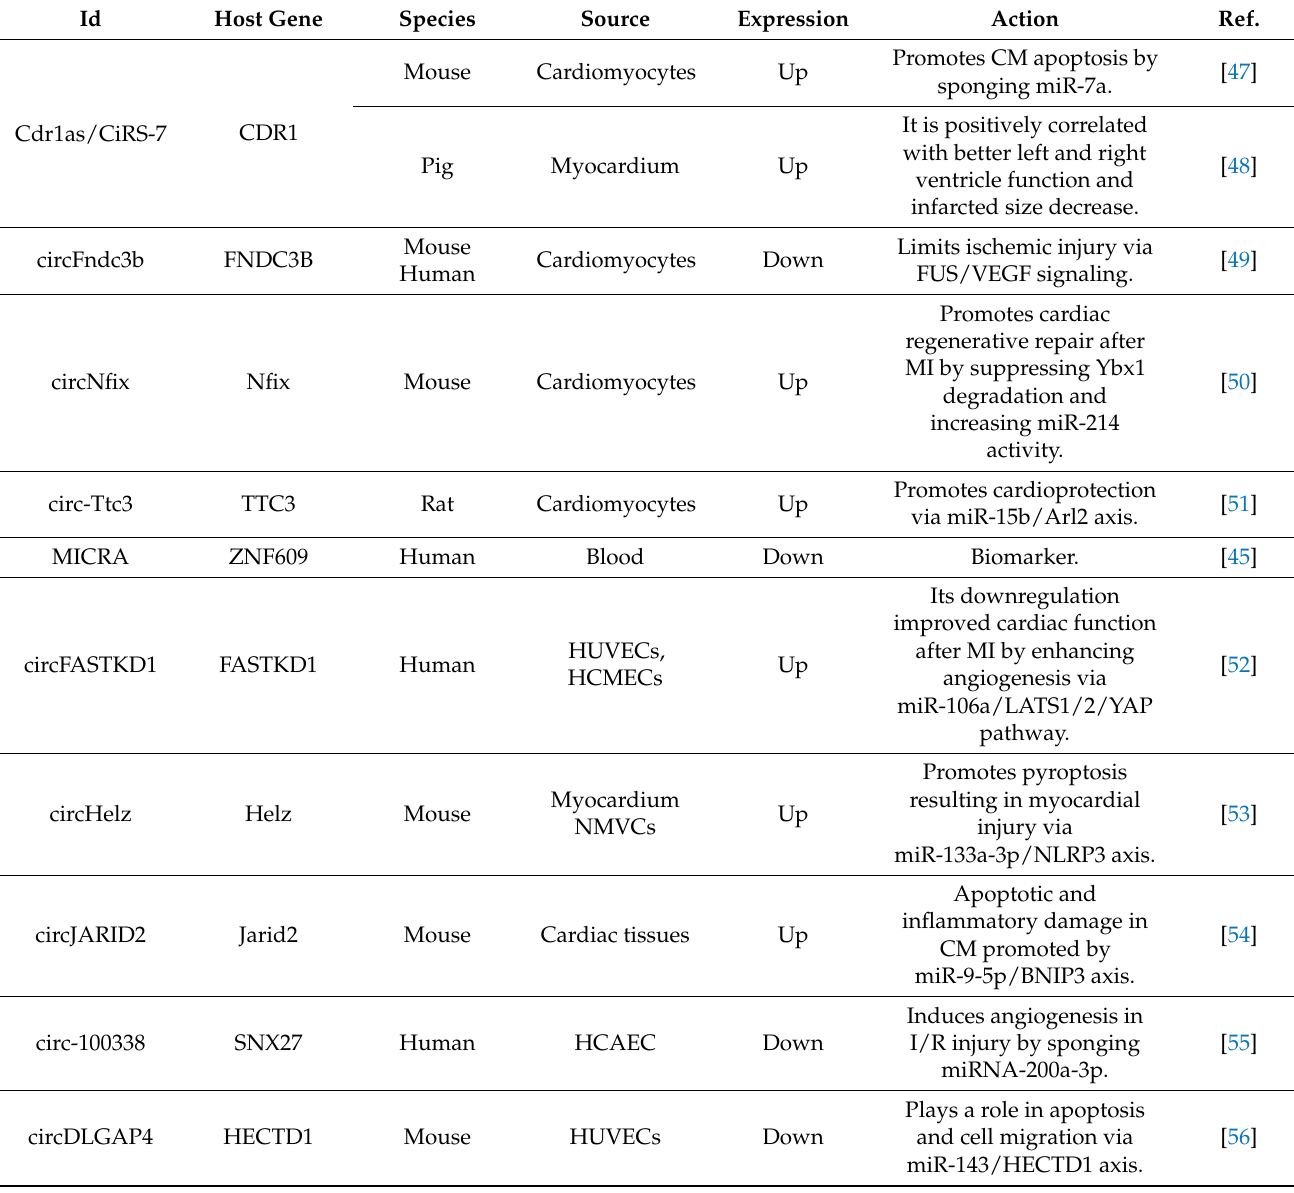
Table 2. List of circRNAs associated with myocardial infarction and I/R